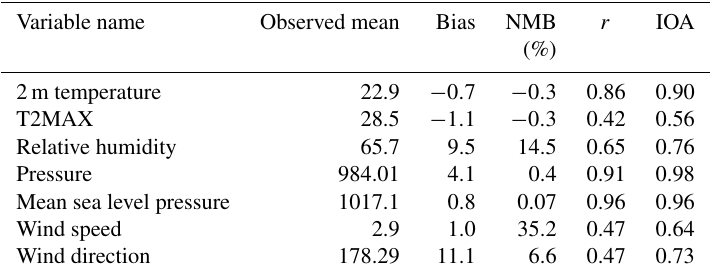
Table 2. Observed mean and simulation summary statistics for meteorological parameters. The bias, normalized mean bias (NMB), corre- lation coefficient ( r ), and index of agreement (IOA) are calculated between simulated and observed meteorological parameters at the DWD stations during the 6–13 August 2015 period.